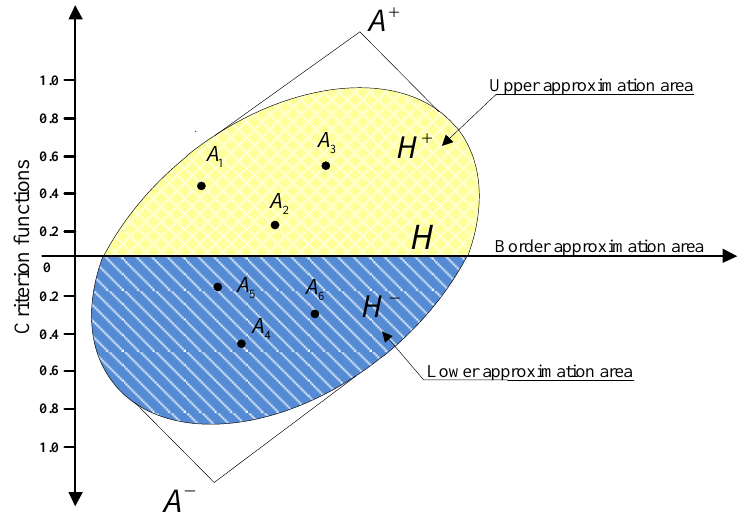
− ) and border ( H ) approximation